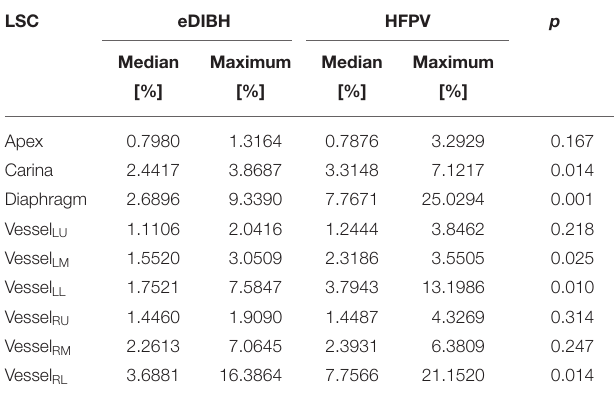
TABLE 3 | Median and maximum relative error [%] of radial distances between reference (Ref SC ) and selected anatomical structures (LSC i ), including significance of difference between corresponding distributions of eDIBH and HFPV according to Wilcoxon signed rank